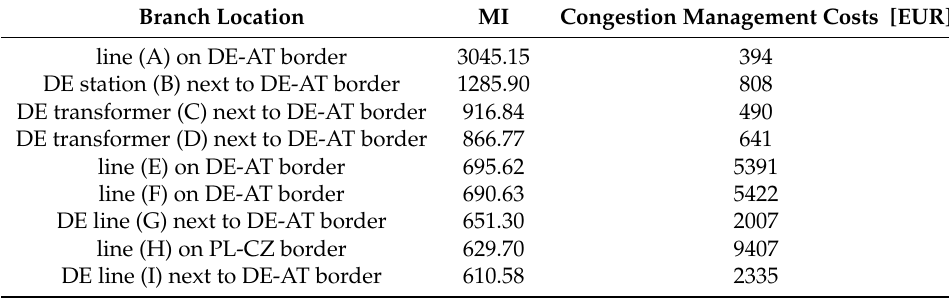
Table 3. Top 9 (cut-off at multiplier indicator (MI) = 600) branches according to the multiplier indicators and congestion management costs, aggregated over 24 grid scenarios, obtained after placing a new PST at a given branch. (The letters A–I in parentheses serve as identifiers of locations to be compared with congestion factor (CF) results in Table 4 below). Source: own